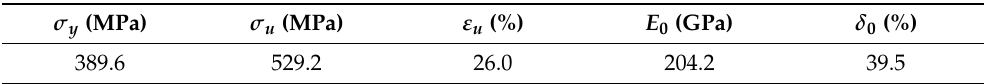
Table 2. Monotonic tensile properties of Q345 steel.